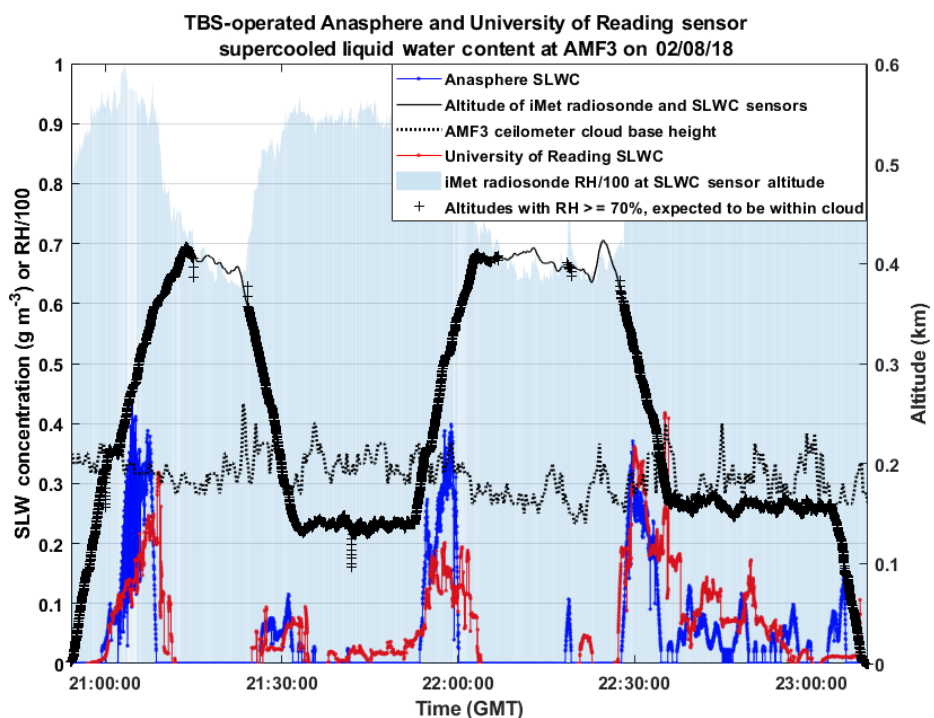
Figure 9. Time series of 2 August 2018 TBS flight with Anasphere and Reading SLWC data, sensor altitude and relative humidity, and cloud base